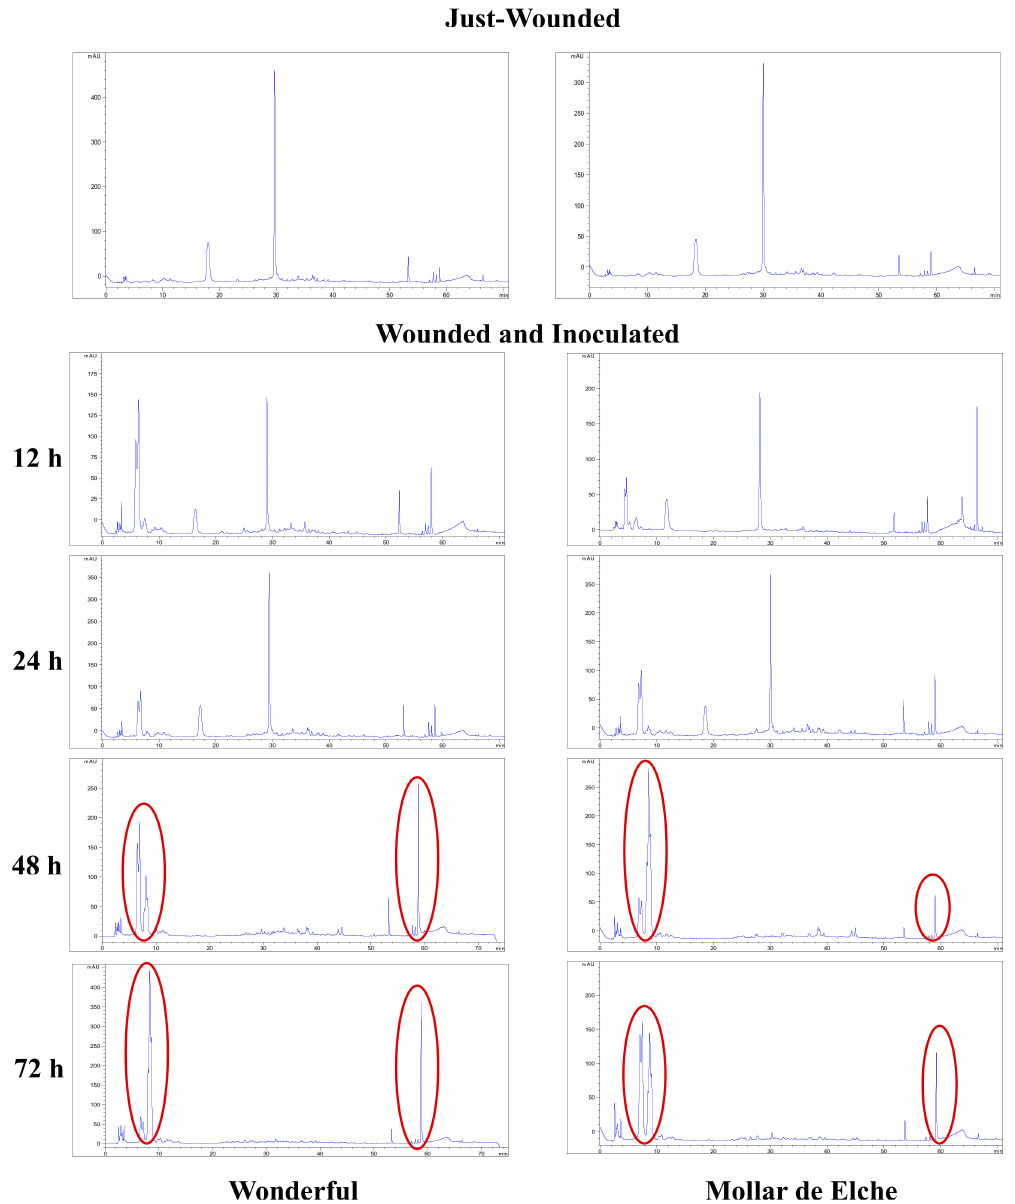
Figure 5. HPLC-UV / DAD chromatograms of ‘Wonderful’ and ‘Mollar de Elche’ rind extracts. Fruits were just-wounded or wounded and inoculated by P. granati . Cultivars were compared at 12–72 h post-inoculation. Punicalagin hydrolysis products are circled by red